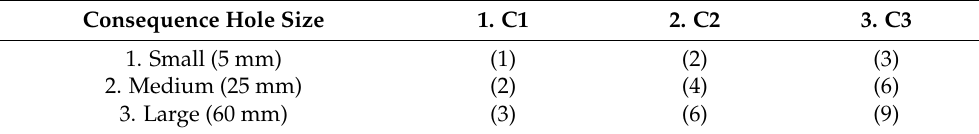
Table 7. Matrix of the size of